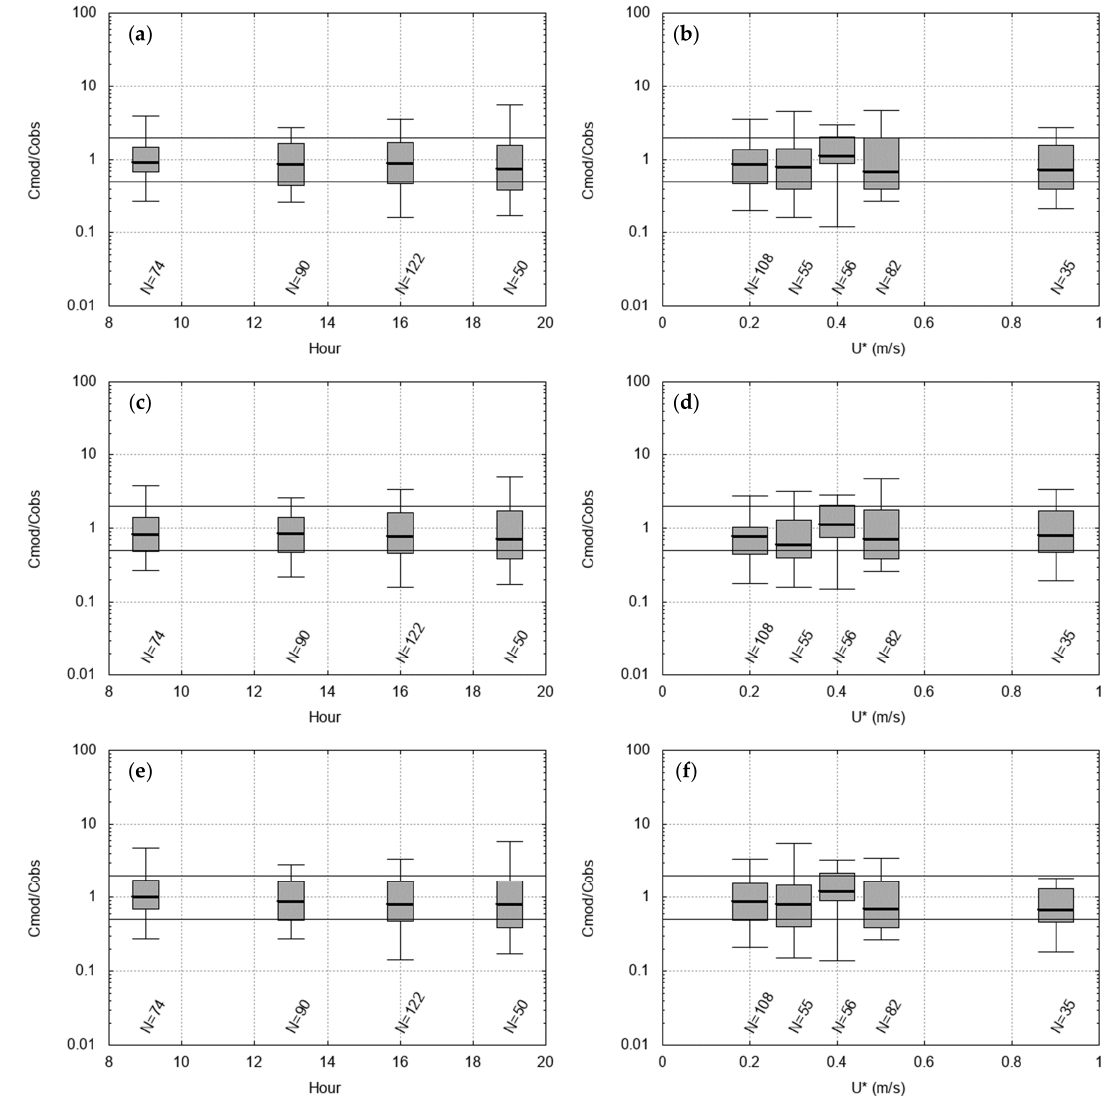
Figure 6. Residual box plots with respect to period of the day and friction velocity for Kincaid SF 6 best-quality data: ( a ) WT plume rise, period of the day; ( b ) WT plume rise, friction velocity; ( c ) JJ + RS plume rise, period of the day; ( d ) JJ + RS plume rise, friction velocity; ( e ) JJ + JJ plume rise, period of the day; ( f ) JJ + JJ plume rise, friction velocity.